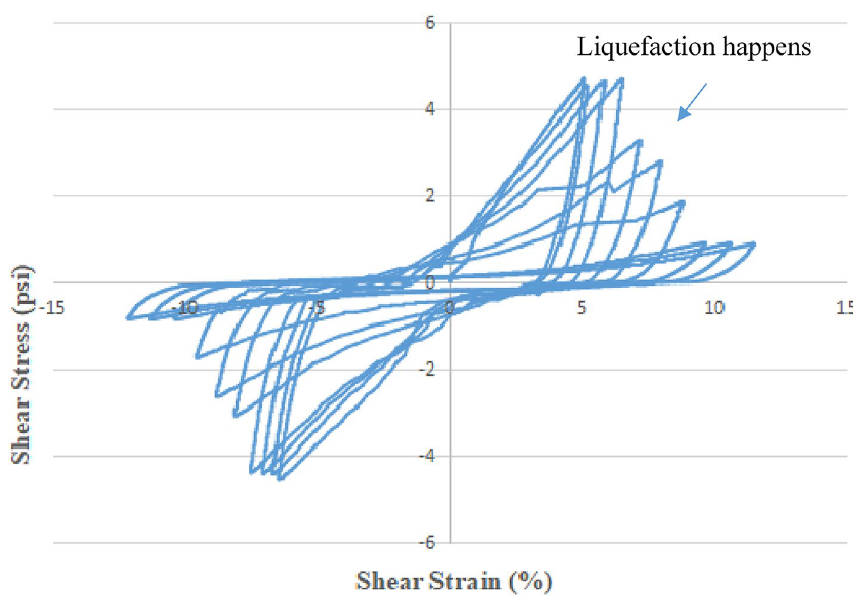
Figure 11. Cyclic shear stress versus shear strain in cyclic hollow cylinder